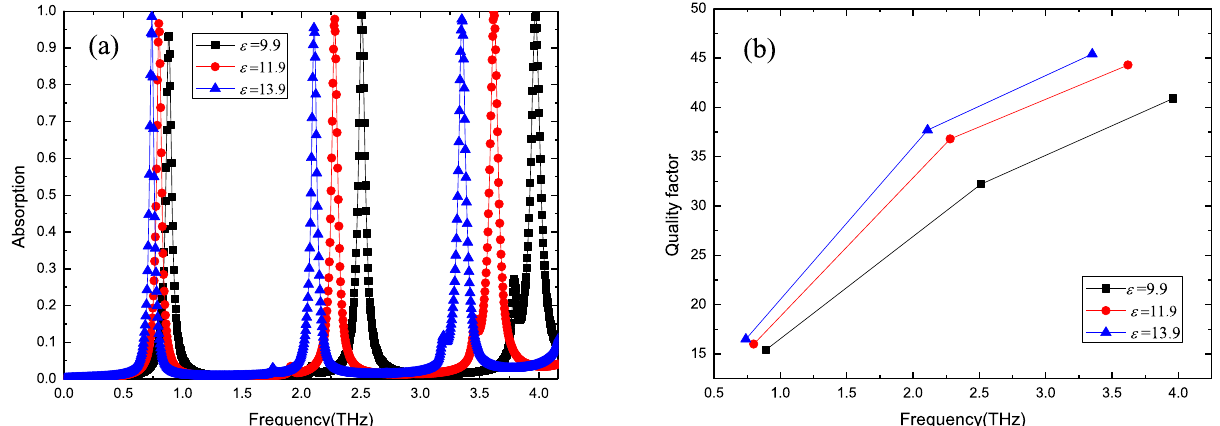
Fig. 8. The impact of dielectric constant e on the (a) absorption; (b) quality factor.